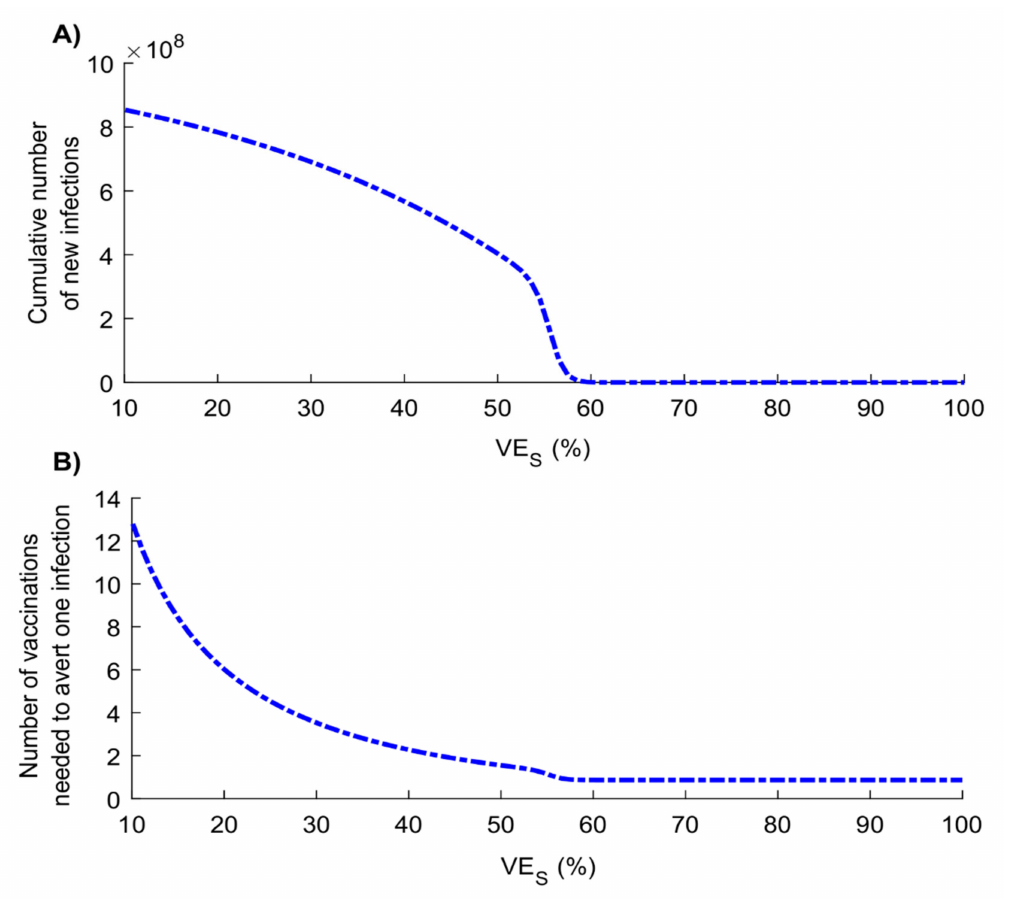
Figure 5. Impact of varying levels of vaccine e ffi cacy in reducing susceptibility ( VE s ) on ( A ) cumulative number of new SARS-CoV-2 infections (final epidemic size) and ( B ) number of vaccinated persons needed to avert one SARS-CoV-2 infection. Scenario assumes vaccine scale-up to 80% coverage before epidemic onset. Duration of vaccine protection is 10 years. Measures are assessed at the end of the epidemic cycle, that is, after the epidemic has reached its peak and declined to a negligible